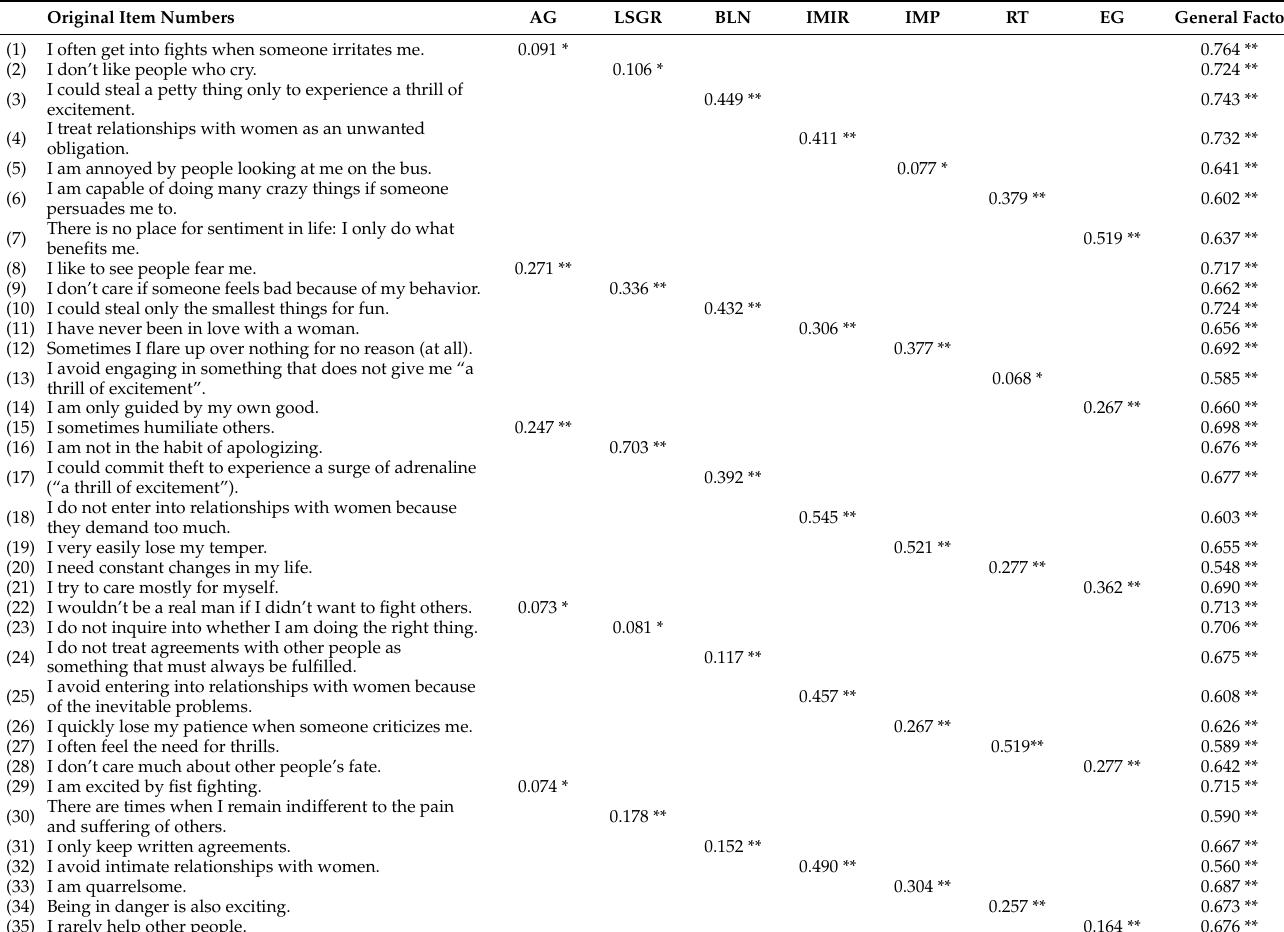
Table 5. Standardized factor loadings for the general factor and the factors representing seven antisocial